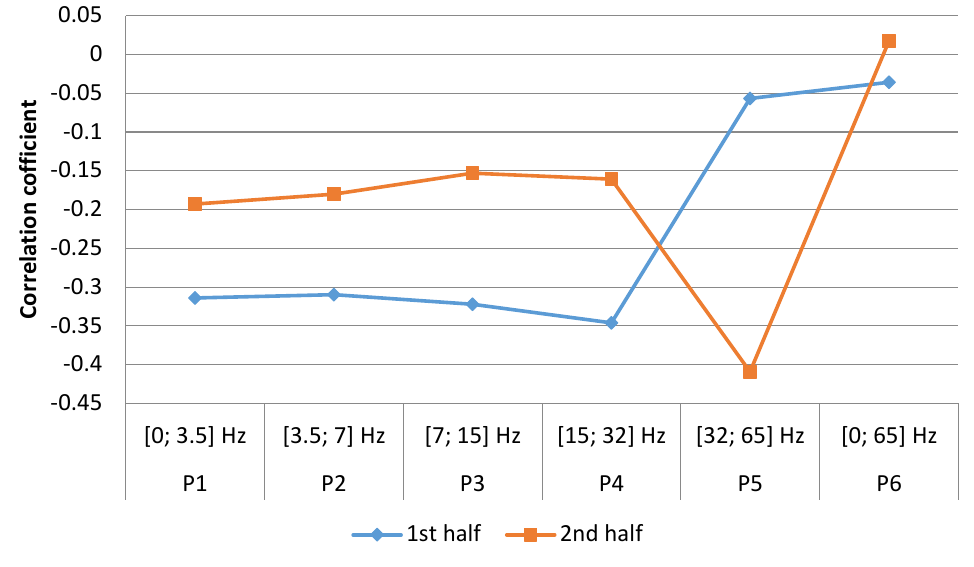
Figure 11. Correlation between number of men cases of MI per week and mean magnetic power in different frequencies for older (>63 years age) men group for first and second half for year 2016 (data from LUHS, Cardiology clinic, 2016).